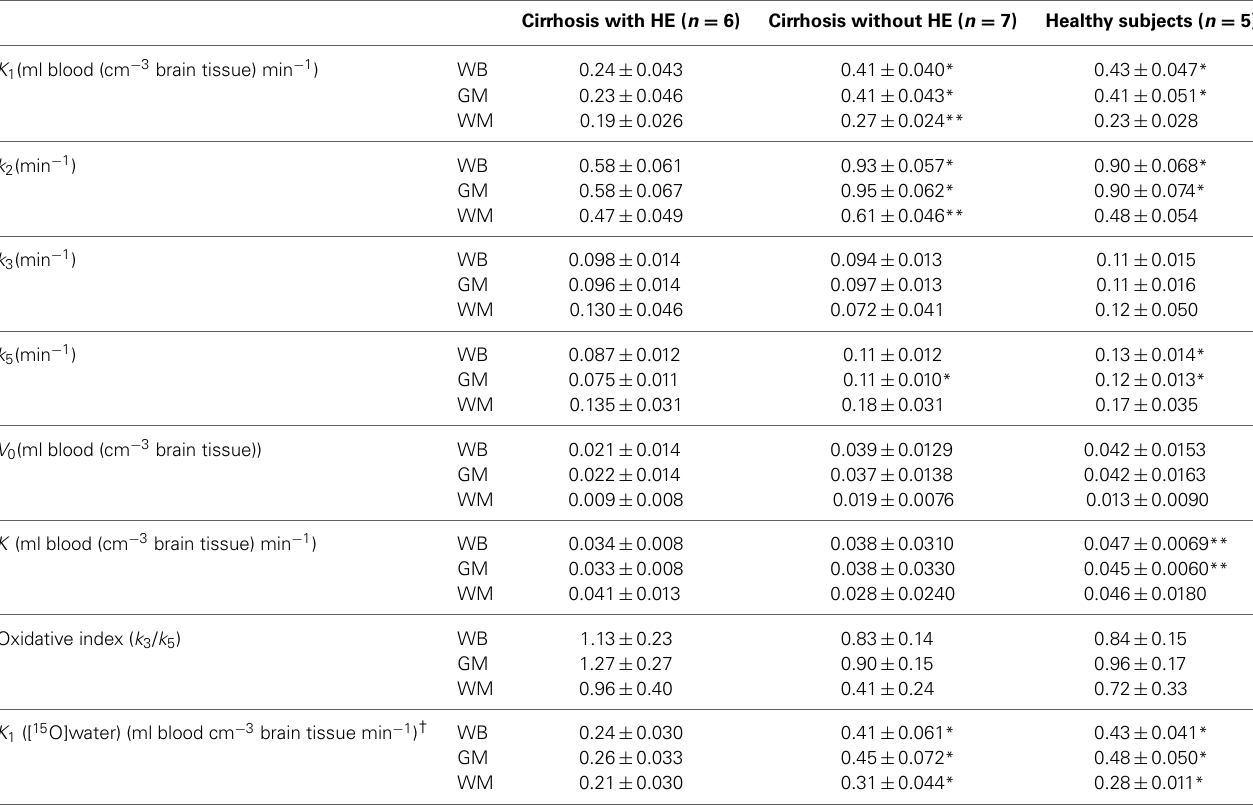
Table 2 | Parameters of brain [ 11 C]acetate